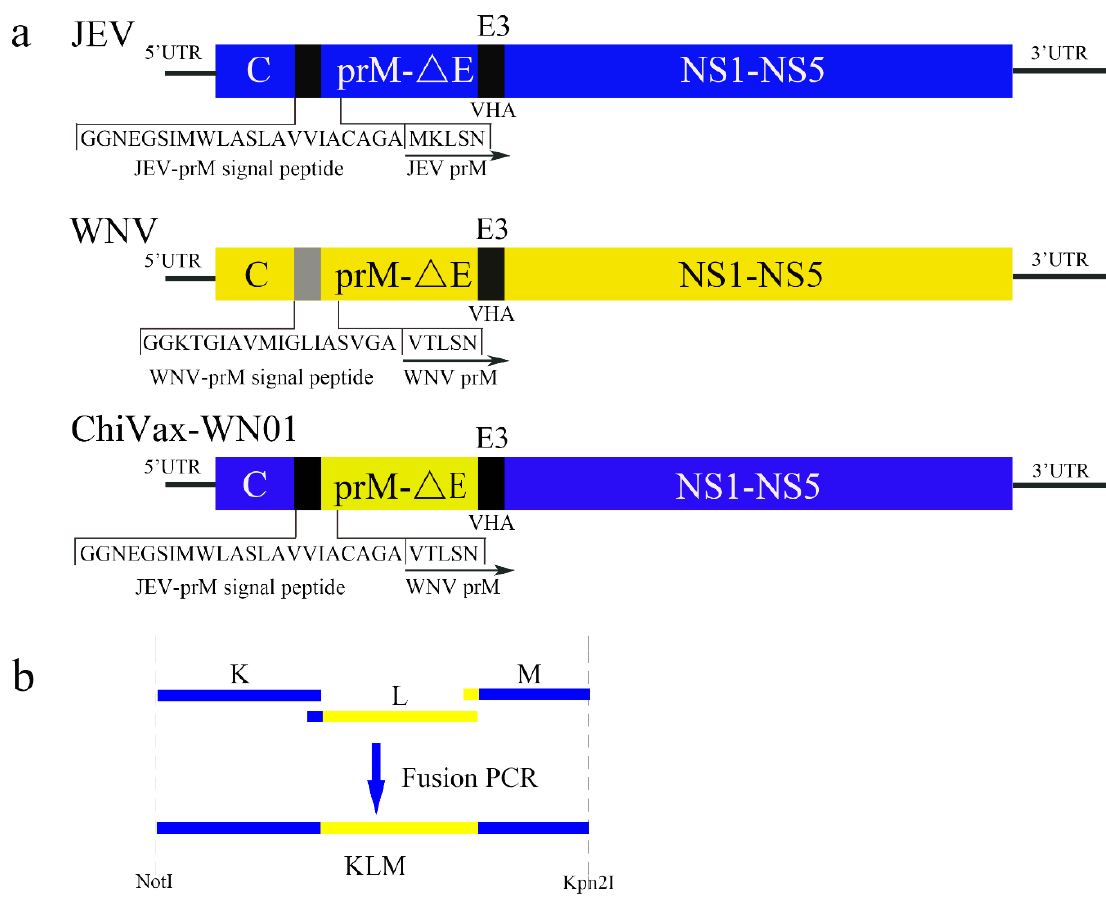
Figure 1. Schematic diagram for the construction of chimeric ChiVax-WN01. ( a ) Replacement of WNV prM Δ E with that of JEV SA14-14-2: Δ E represented the E protein without the last three amino acids at the carboxyl terminus. E3 referred to the last three amino acids of E protein. ( b ) Introduction of WNV prM Δ E by fusion PCR of fragments K, L, and M.